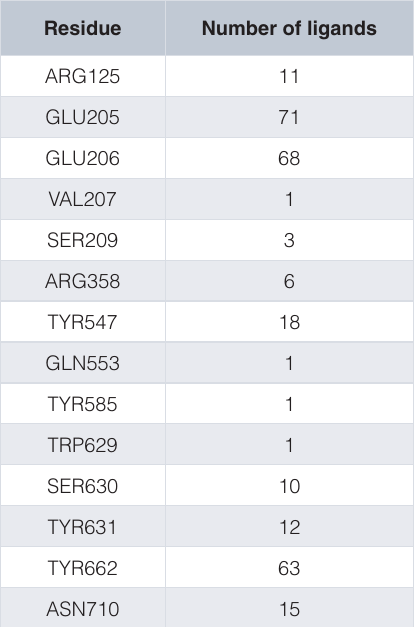
Table 3. Number of times residues from the DPP4 enzyme ligand an inhibitor.